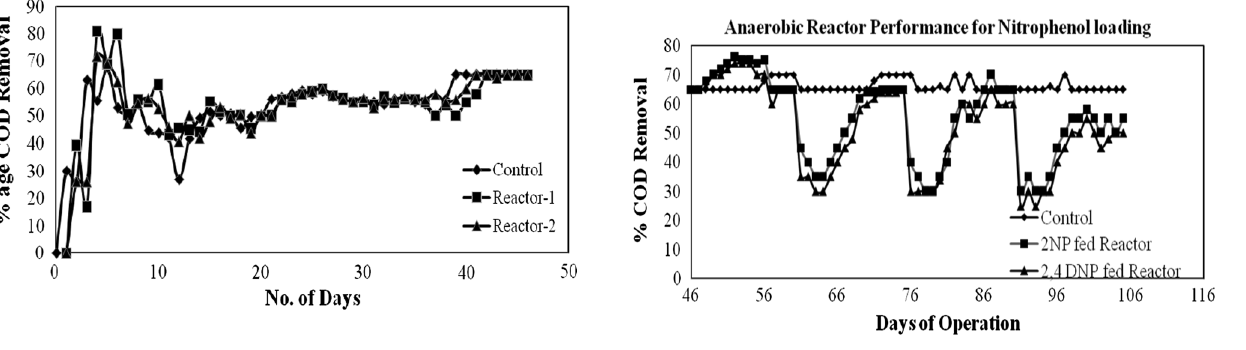
Fig. 3 COD removal of anaerobic reactors during nitrophenol